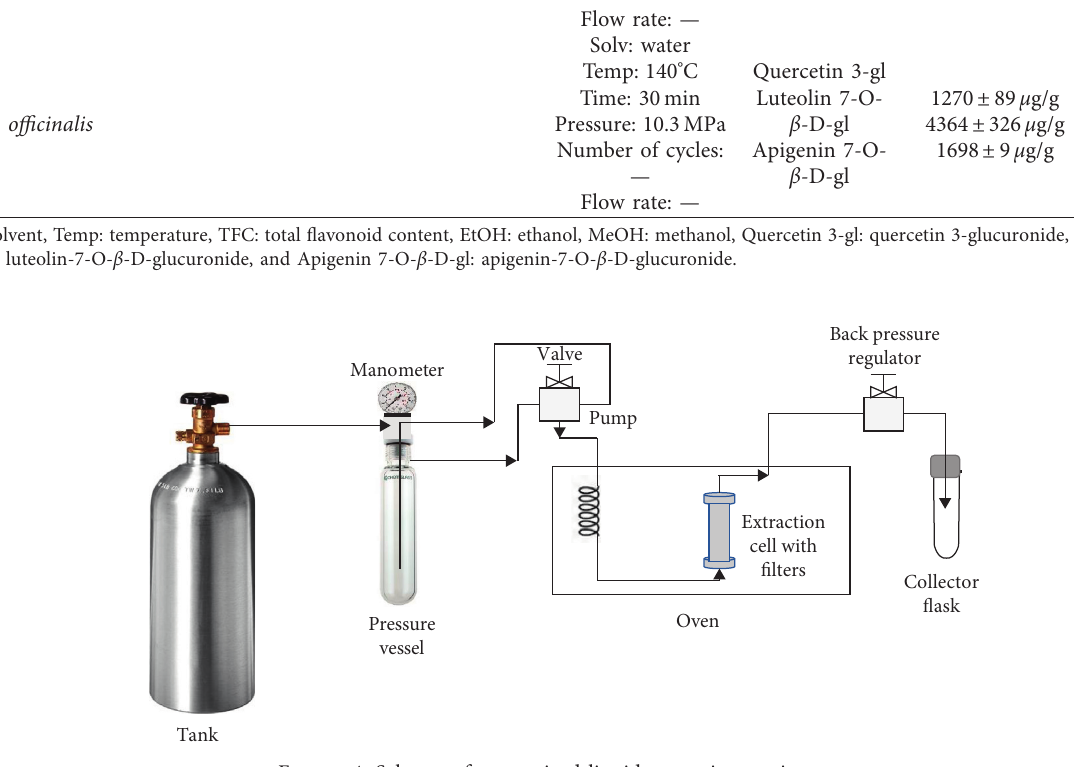
Figure 4: Scheme of pressurized liquid extraction